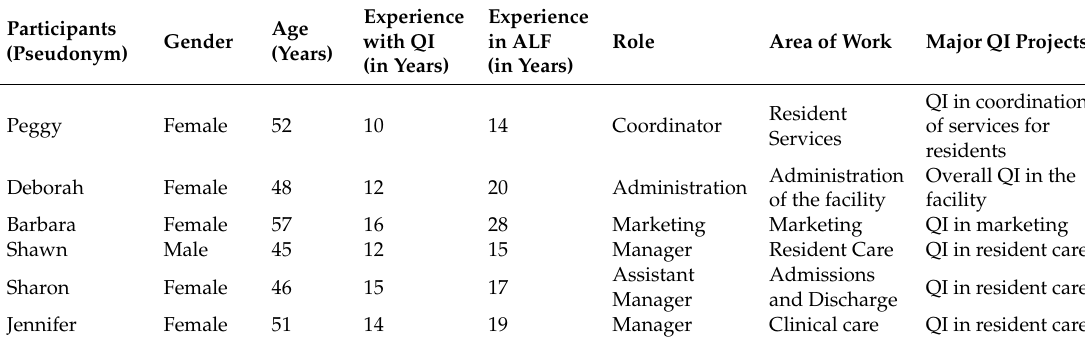
Table 1. Description of